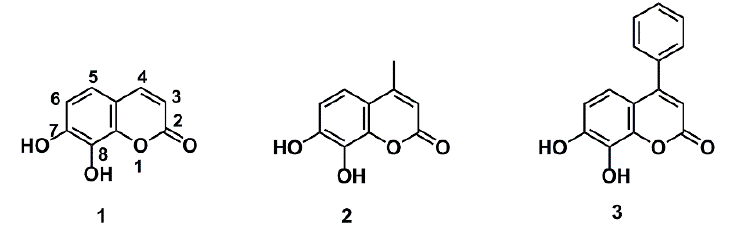
Figure 1. The structure of daphnetin and its analogues.